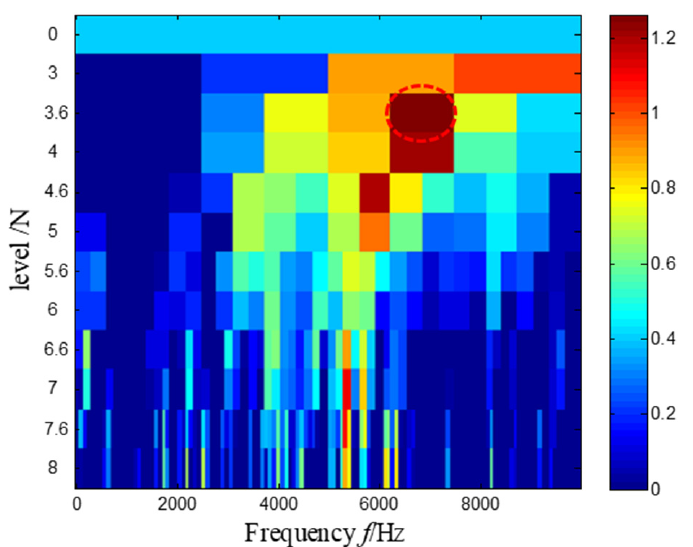
Figure 9. The Kurtogram and the optimal frequency band highlighted by a red dash circle.